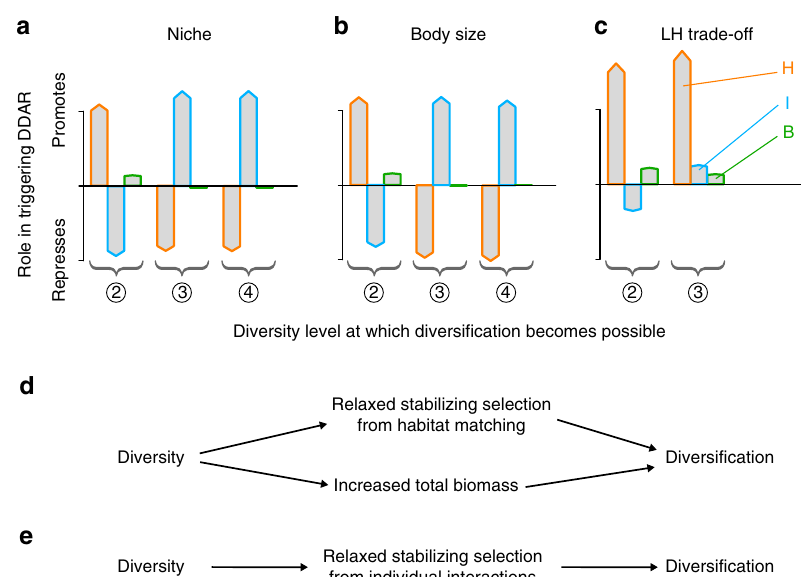
Figure 5 | Selective causes of DDAR. Vertical bars represent, under the three ecological scenarios ( a – c ), the relative contribution (positive or negative) of each component ( H i , I i and B ; equation (1)) in causing bifurcations from ESS to evolutionary diversification as initial diversity increases. We showed separately bifurcations occurring at each diversity level, that is, those that occurred between one and two species, between two and three species, and between three and four species (corresponding to different regions in parameter space; Fig. 3). Synthetic diagrams summarize how diversity positively impacts diversification, at low diversity levels ( d ) and at high-diversity levels ( e